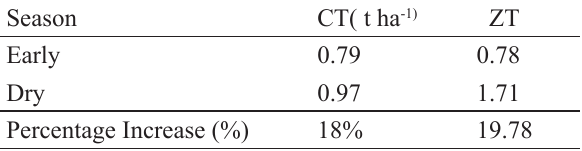
Table 4: Mean Grain Yield of Crops Under Conventionally Tilled and No-Till During Early and Late Seasons Season CT( t ha -1) ZT Early 0.79 0.78 Dry 0.97 1.71 Percentage Increase (%) 18% 19.78 Legend: CT = Conventional Tillage, ZT = Zero